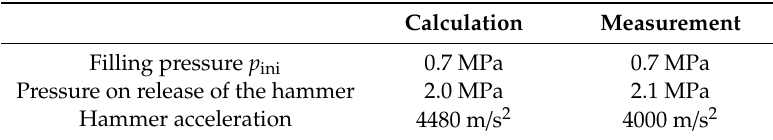
Table 2. Calculated and measured parameter values for the setup with a pneumatically driven hammer.